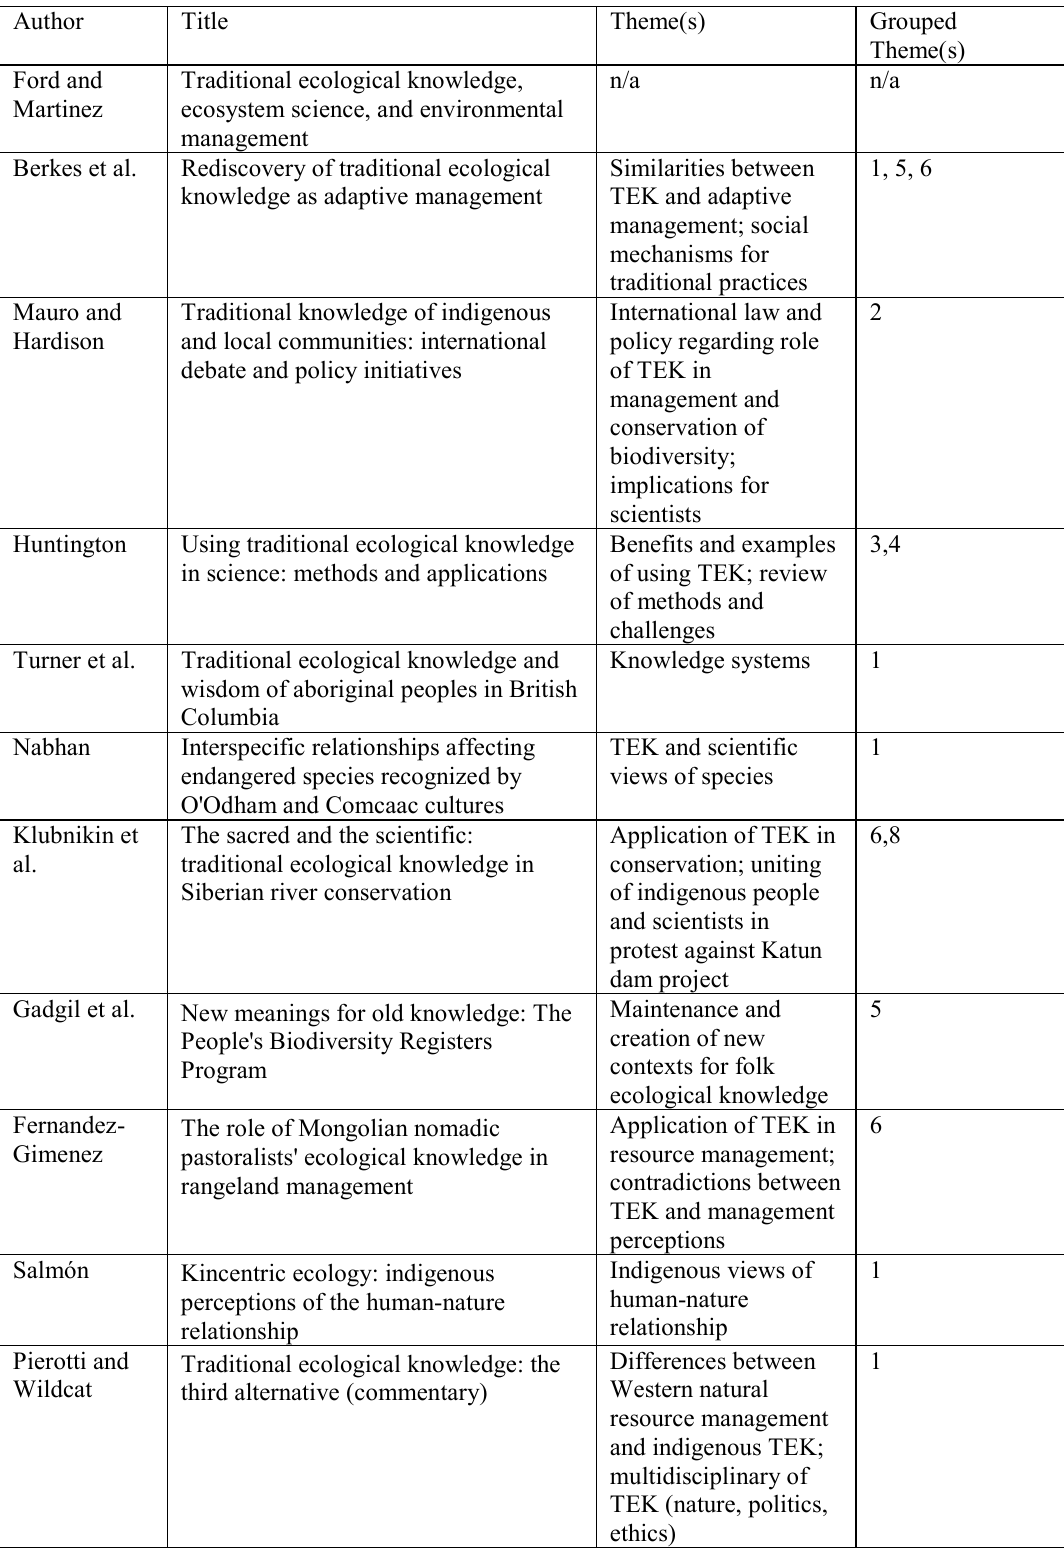
Table A1.1. Summary of papers in Ecological Applications (2000)